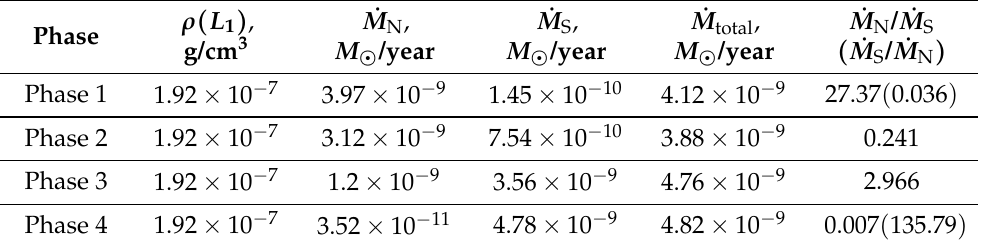
Table 4. Parameters of accretion of matter on the white dwarf in the asynchronous polar with non-offset dipole for various phases of switching the flow from the north pole to the south one.